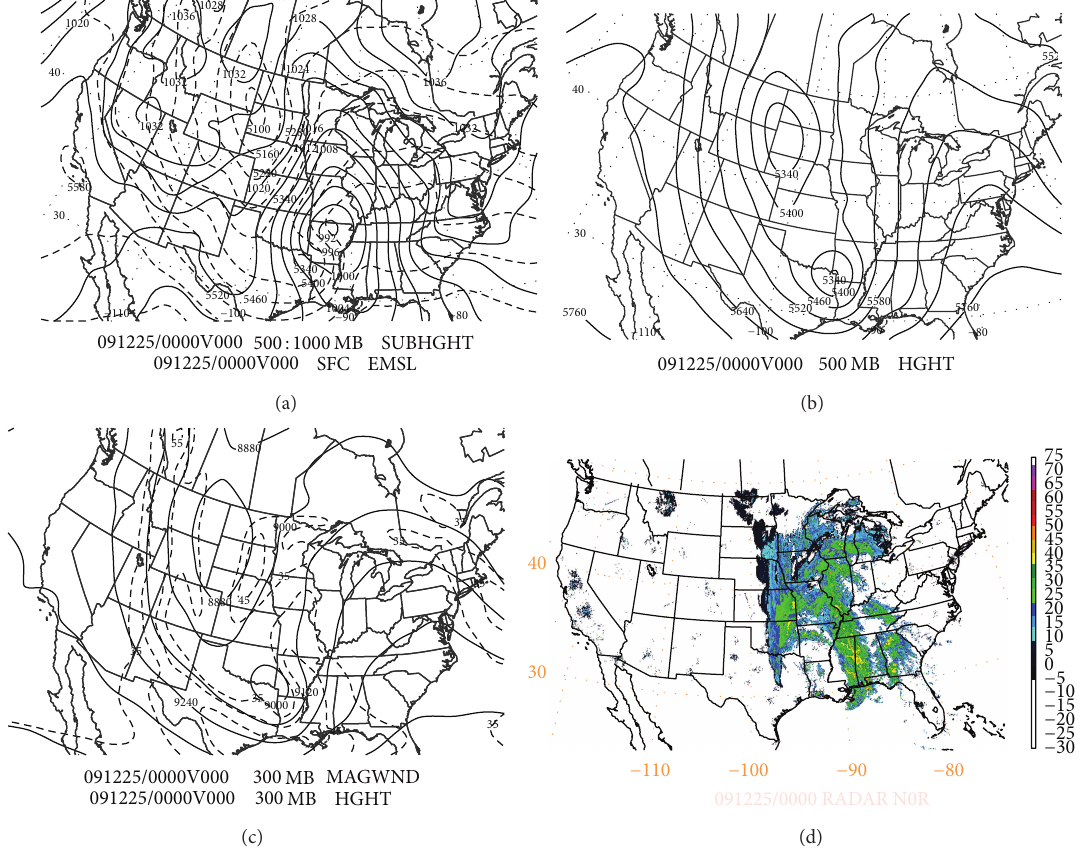
Figure 2: Maps and analyses for 0000 UTC 25 December 2009, where (a) is the mean sea level pressure (solid, every 4 hPa) and 1000–500-hPa geopotential thickness (dashed, every 60gpm) from NAM Eta initialization, (b) the 500 hPa geopotential heights (solid, every 60 gpm), (c) the 300-hPa geopotential heights (solid, every 120gpm) and the wind speeds (dashed, every 10ms −1 , at 35 ms −1 , 45 ms −1 , and 55 ms −1 ), and (d) the Doppler radar base reflectivity